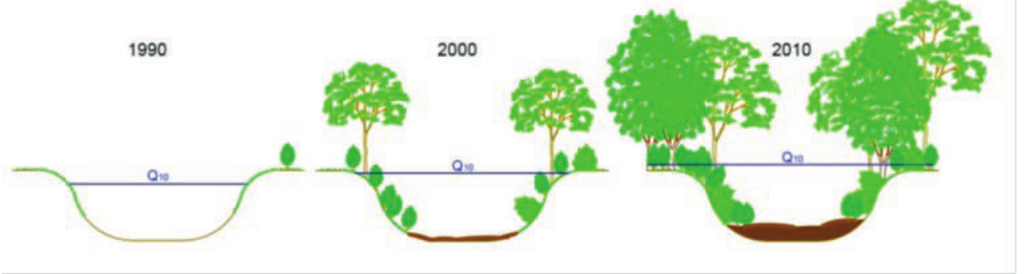
Fig. 1 Consequence of overgrowing